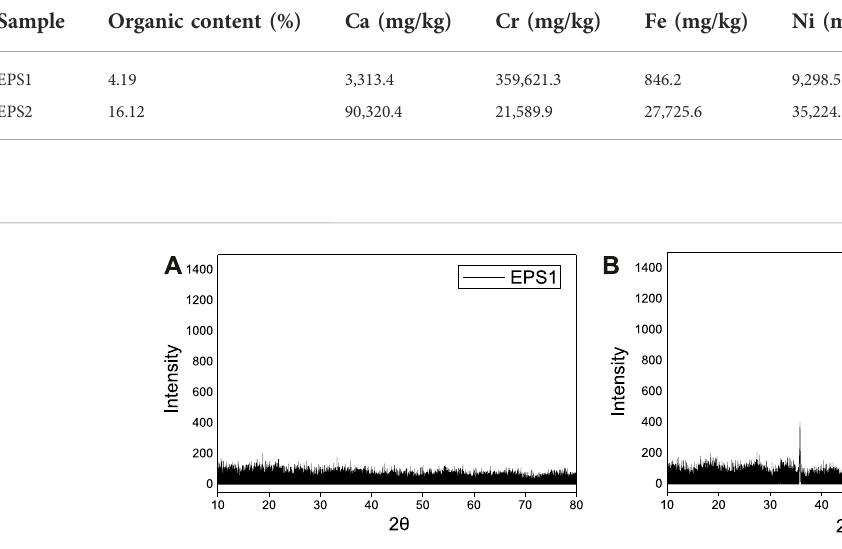
FIGURE 1 XRD pattern of (A) EPS1 and (B) EPS2.